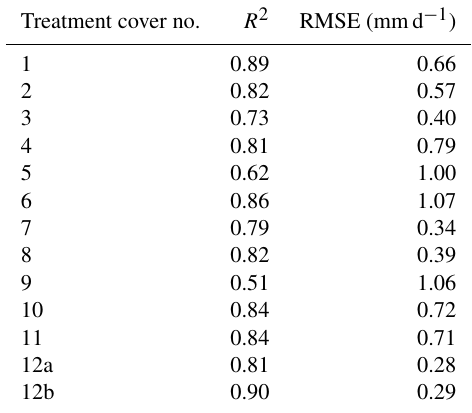
Table 2. Performance statistics ( R 2 and RMSE) of inverse mod- elling for each of 13 treatment covers at the Aurora North Mine site. Treatment cover